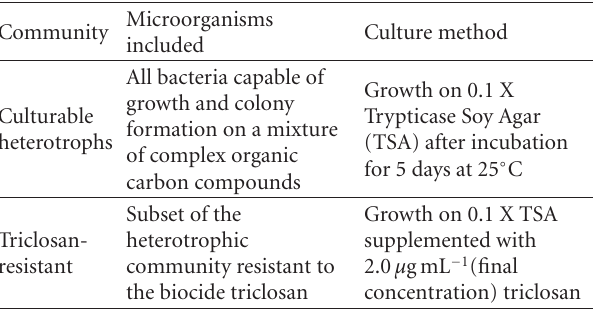
Table 2: Microbial populations in this